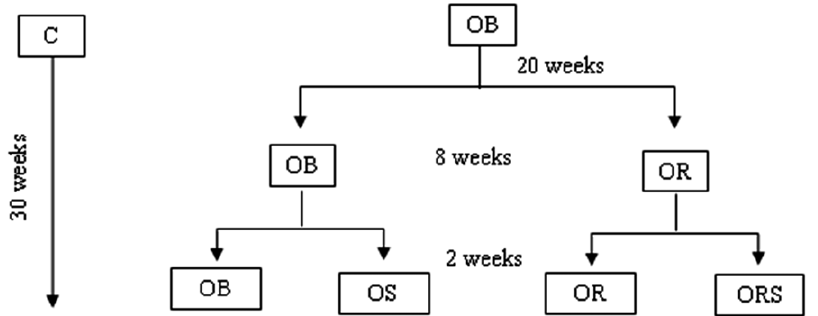
Figure 1. Experimental protocol. Control (C, n=10); obese (OB, n=50), obese given T 3 at 25 m g/100 g BW (OS, n=10), calorie- restricted obese (OR, n=10) and calorie-restricted obese given T 3 at 25 m g/100 g BW (ORS, n=10).